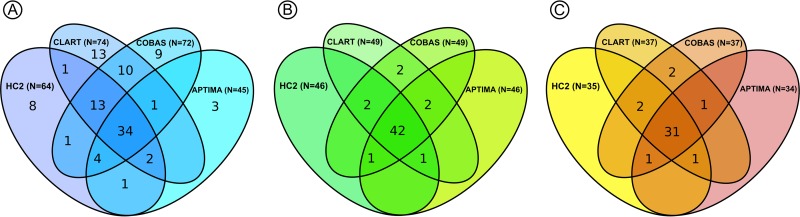
Distribution of histologically confirmed CIN lesions in HPV-positive women with screening samples at age 30 to 65 years, with follow-up from the baseline in June-August 2011 to December 2013. Linkage was performed through the national Patobank. (A) Women with ≤CIN1 (n = 100). (B) Women with ≥CIN2 (n = 50). (C) Women with ≥CIN3 (n = 38).